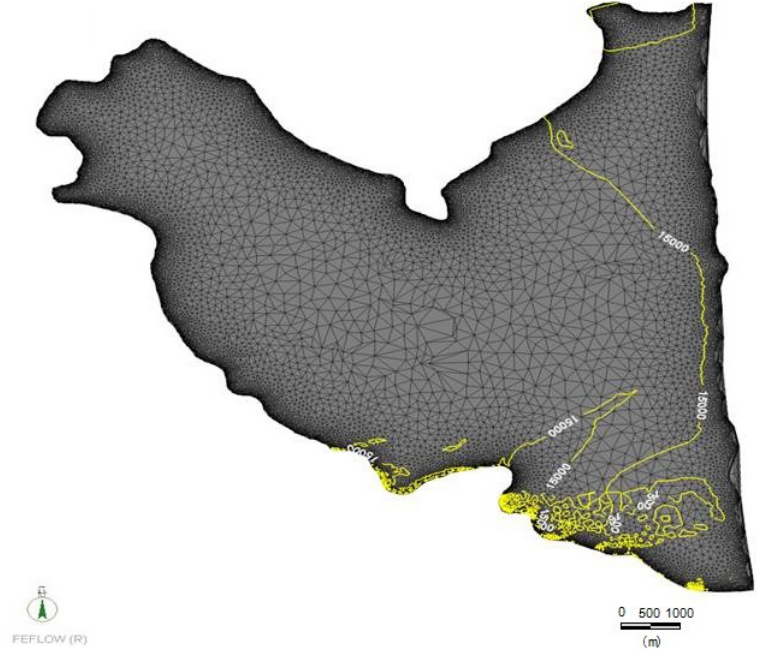
Figure 12. Location of 15,000 mg L − 1 isosalinity contour at 4018 days after using 16 number of pumping wells.